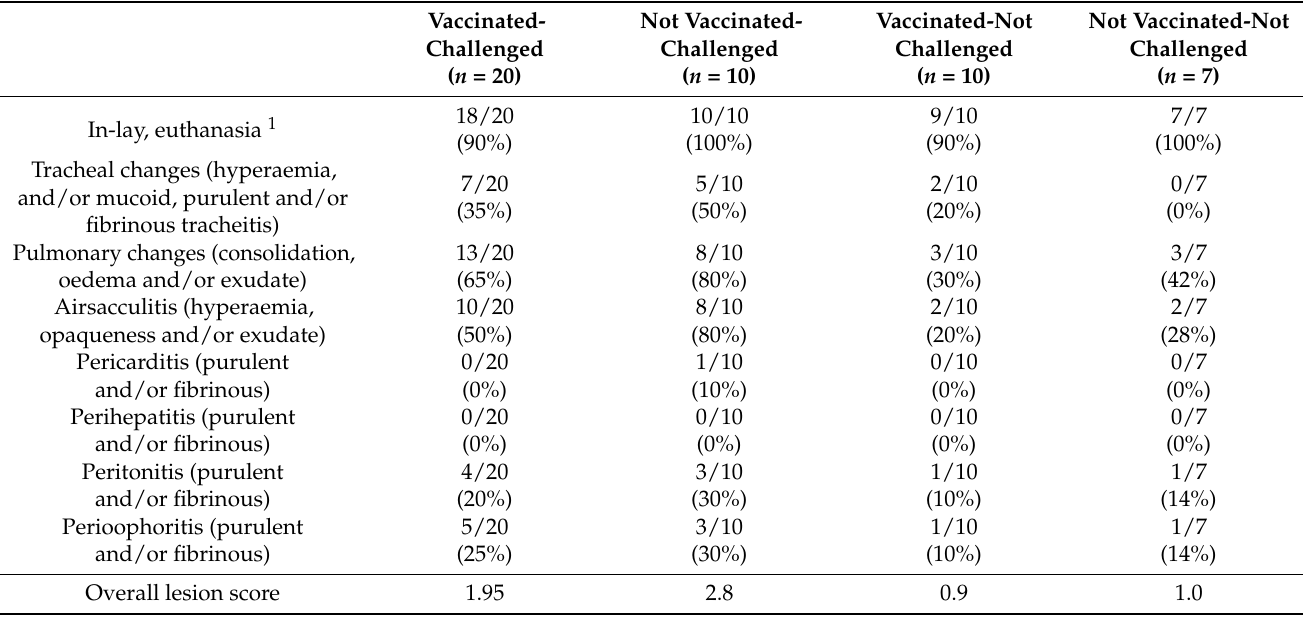
Table 1. An overview of the gross pathological manifestations observed.